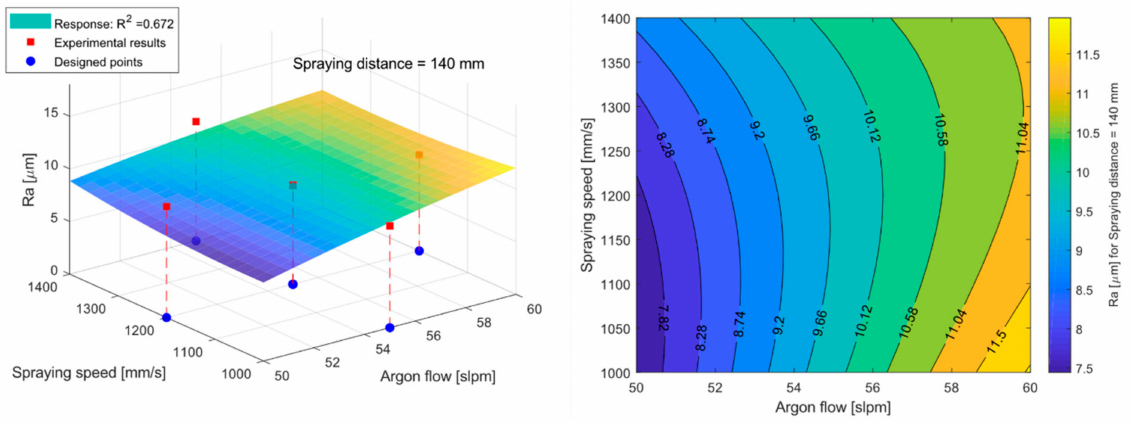
Figure 8. Response surface of the obtained Ra for a fixed spraying distance of 140